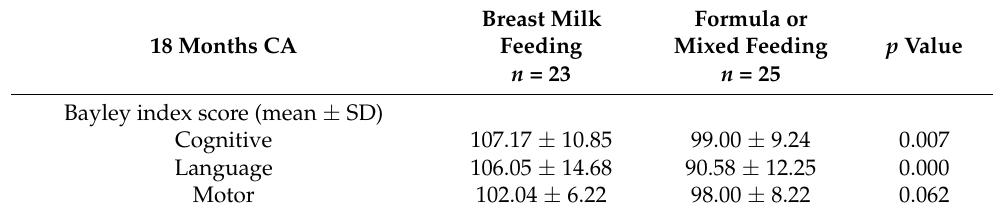
Table 4. Neurodevelopmental outcomes at 18 months CA according to type of toddler feeding. Formula or Breast Milk p Value Mixed Feeding 18 Months CA Feeding n = 25 n = 23 Bayley index score (mean ± SD) Cognitive 107.17 ± 10.85 99.00 ± 9.24 0.007 Language 106.05 ± 14.68 90.58 ± 12.25 0.000 Motor 102.04 ± 6.22 98.00 ± 8.22 0.062